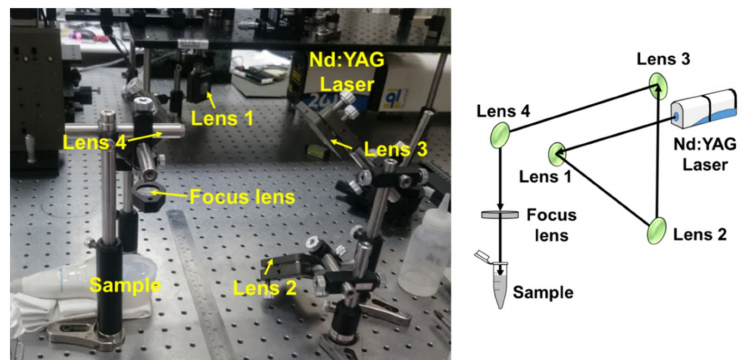
Figure 1. A Nd:YAG laser setup for measuring laser-induced microbubble (MB)